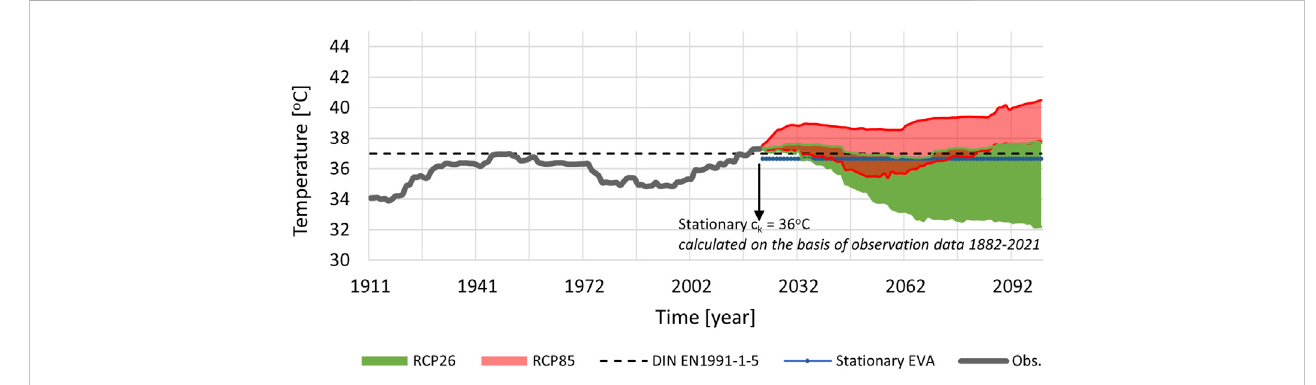
FIGURE 4 Non-stationarycharacteristicvalues c k (n) correspondingto2%probabilityofexceedance